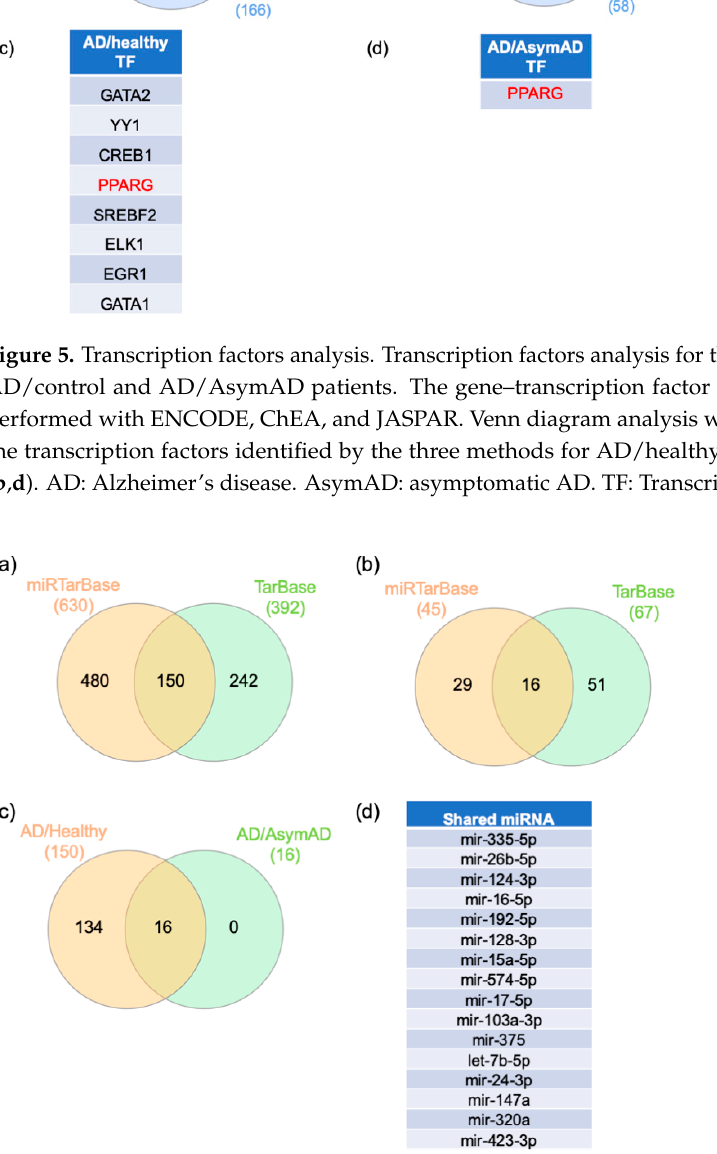
Figure 5. Transcription factors analysis. Transcription factors analysis for the entorhinal cortex from AD/control and AD/AsymAD patients. The gene–transcription factor interaction network was performed with ENCODE, ChEA, and JASPAR. Venn diagram analysis was performed to identify the transcription factors identified by the three methods for AD/healthy ( a , c ) and AD/AsymAD ( b , d ). AD: Alzheimer’s disease. AsymAD: asymptomatic AD. TF: Transcription fac- tor.